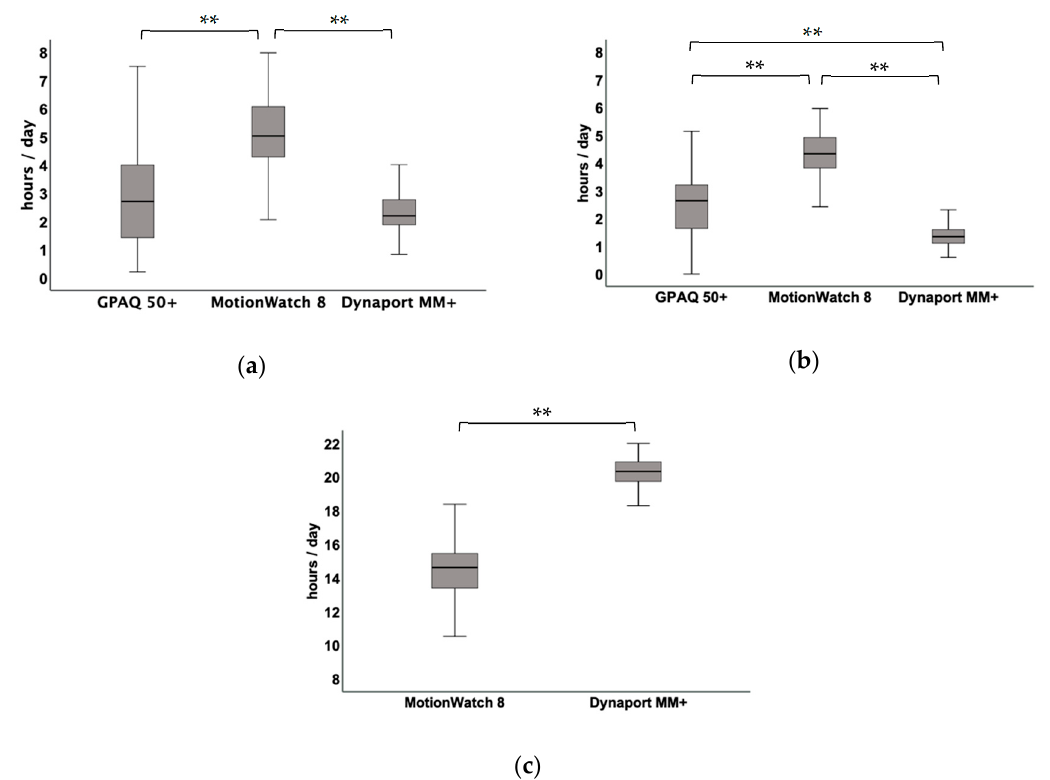
Figure 1. Box-plot illustration of German Physical Activity Questionnaire 50+, MotionWatch8 and MoveMonitor+ derived total duration [hour/day] of physical activity intensity and sedentariness: ( a ) moderate to vigorous intensity (Friedman-test with Bonferroni post-hoc test); ( b ) light intensity (repeated measurement analysis of variance with Bonferroni post-hoc test); and, ( c ) sedentariness ( t -test for paired samples). ** p ≤